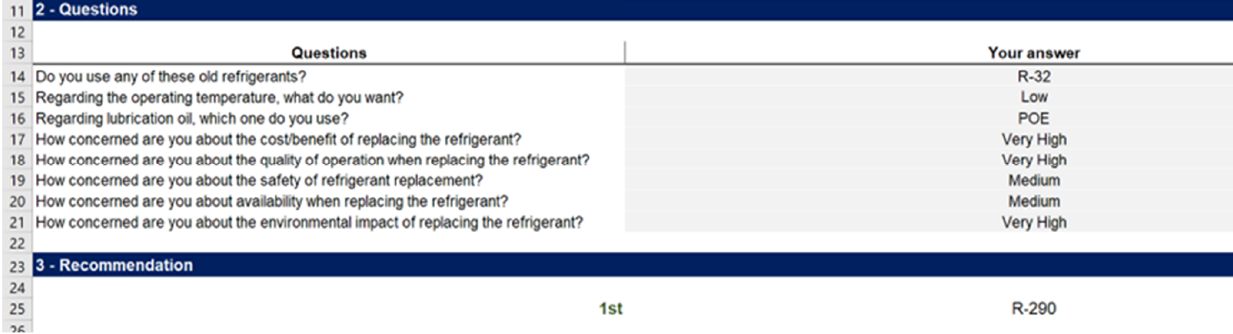
Figure 8. Answers from the company for the replacement of R-32.